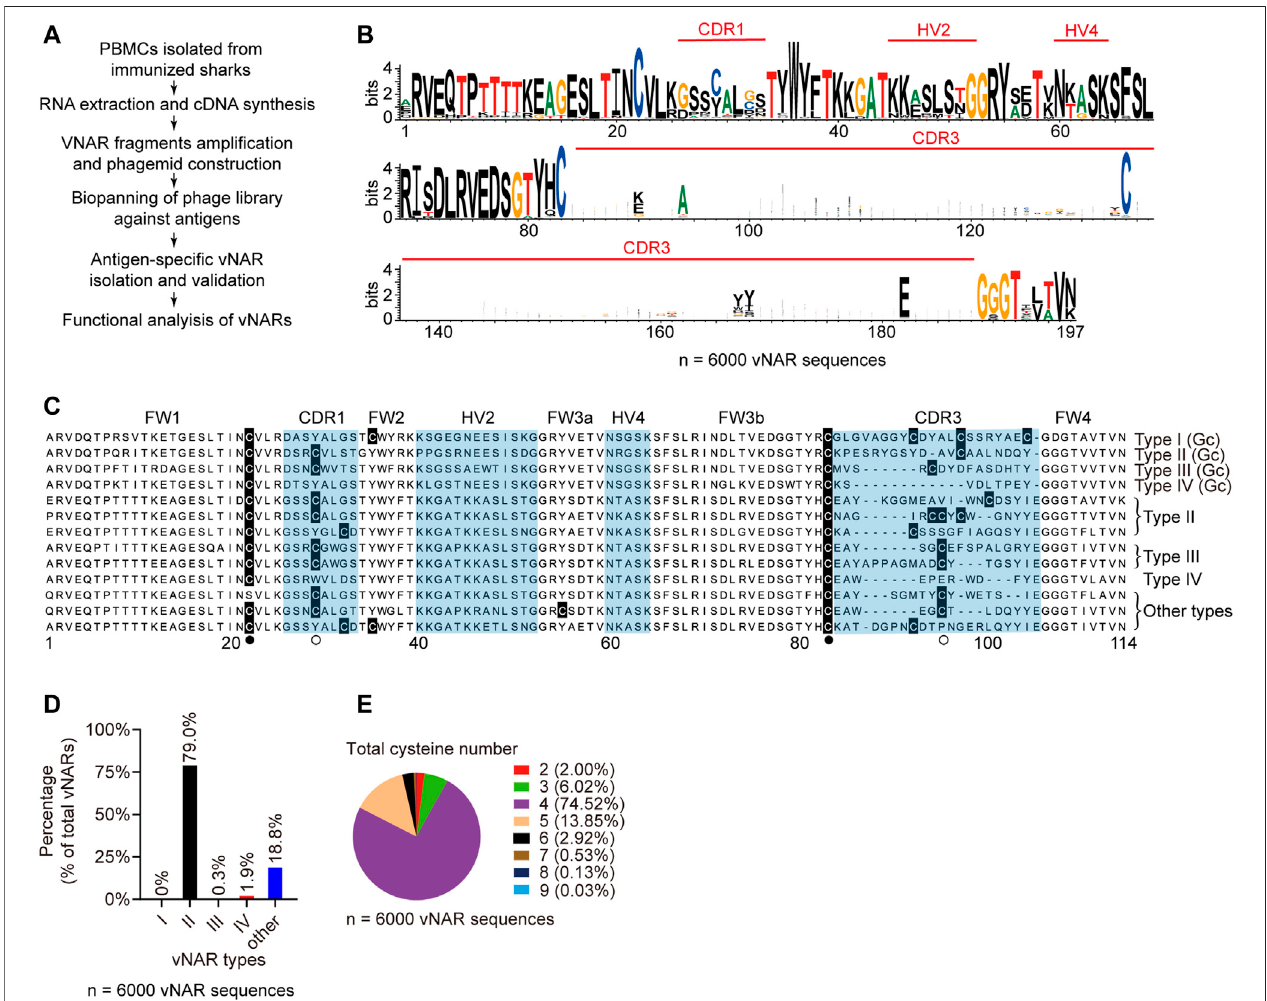
FIGURE4| CharacteristicsofvNARsequencesfromimmunizedlibrary. (A) SchematicforvNARphagelibraryconstructionfromimmunizedsharks. (B) Aminoacid variability for vNAR sequences ( N (cid:1) 6,000). (C, D) Sequence alignment (C) and percentages (D) of different vNAR types in the library. (E) Percentages of vNARs with different cysteine